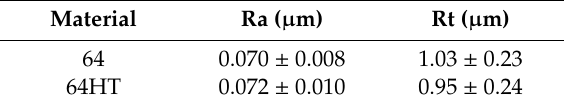
Table 1. Surface roughness data of the Ti-6Al-4V samples. Data represent mean ± SD (n =